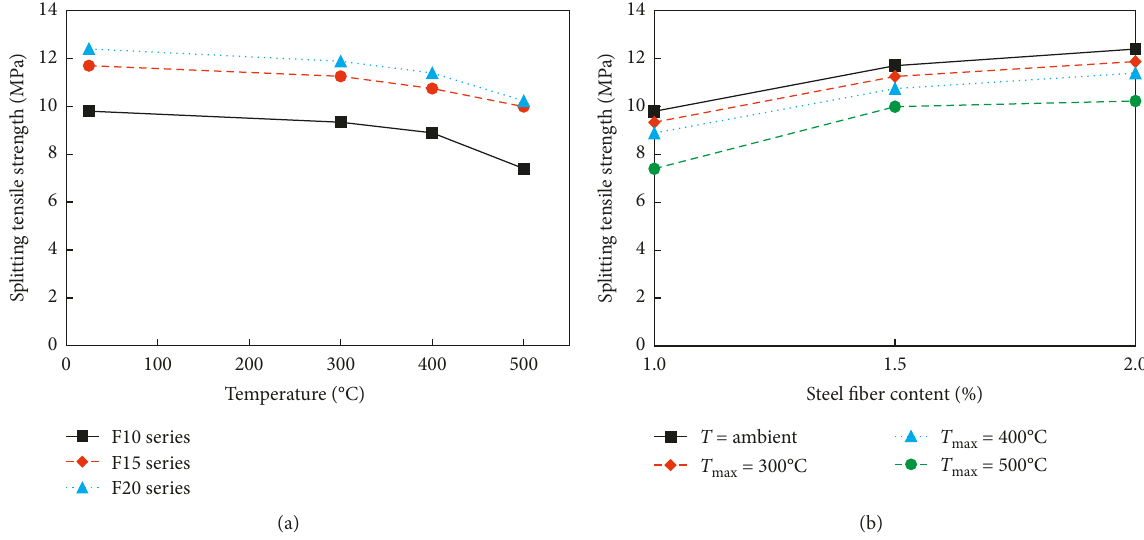
Figure 6: Splitting tensile strength test results. (a) Relationship between the tensile strength and the maximum temperature. (b) Re- lationship between tensile strength and steel fiber